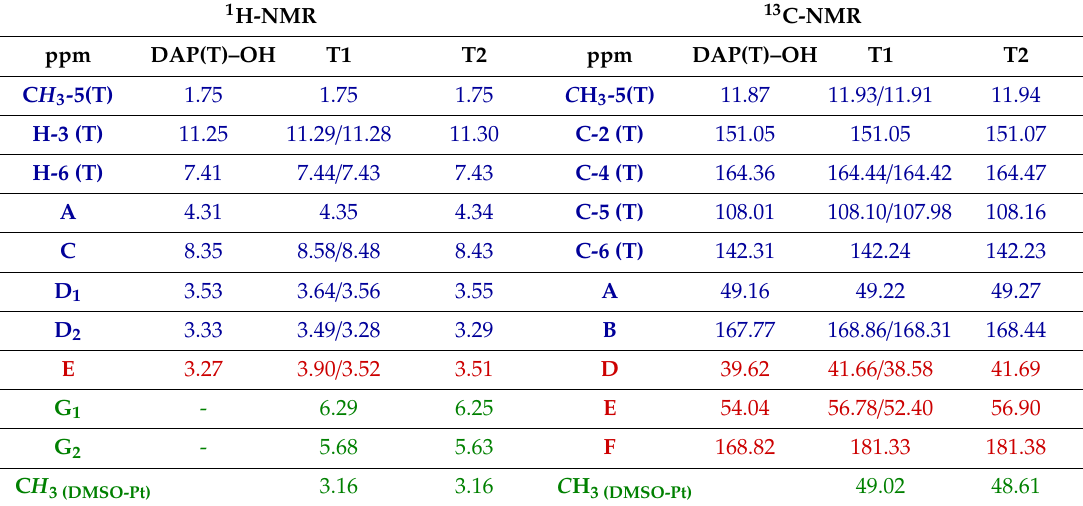
Table 1. Nuclear magnetic resonance (NMR)-chemical shift assignments for T1 and T2 metal complexes compared to those of the starting nucleoamino acid DAP(T)–OH (spectra recorded in dimethyl sulfoxide-d 6 (DMSO-d 6 ). Chemical shift values in blue for T1 and T2 indicate signals very similar to those of the starting ligand, whereas those in red are the most diverging ones; green-colored chemical shift values evidence proton and carbon signals of T1 and T2 not present in the starting nucleoamino